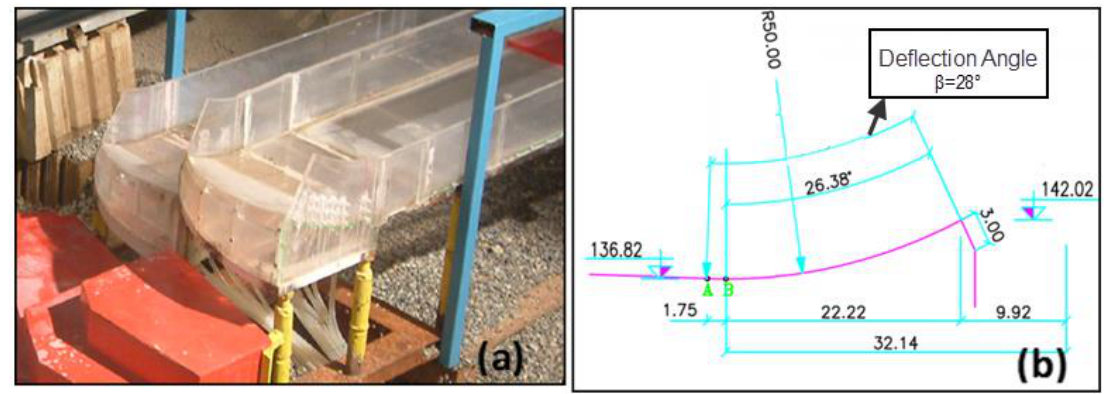
Figure 2. (a) Gotwand hydraulic model of the flip Buckets; (b) Geometry characteristics of the left bucket (all dimensions in